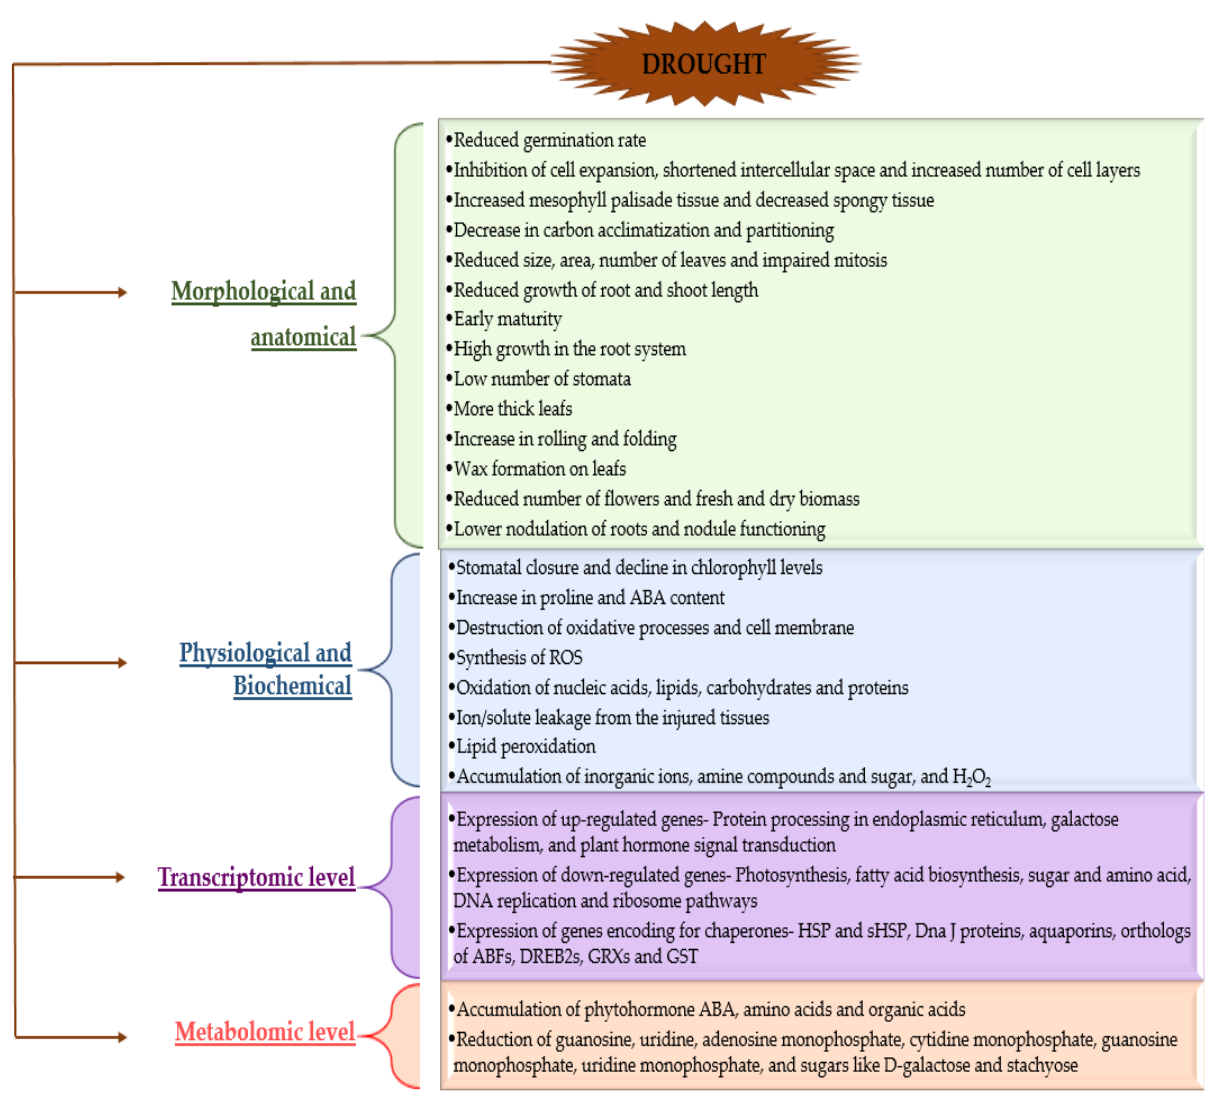
Figure 2. Morphological, anatomical, physiological, biochemical, and molecular responses of plants to drought stress. to drought